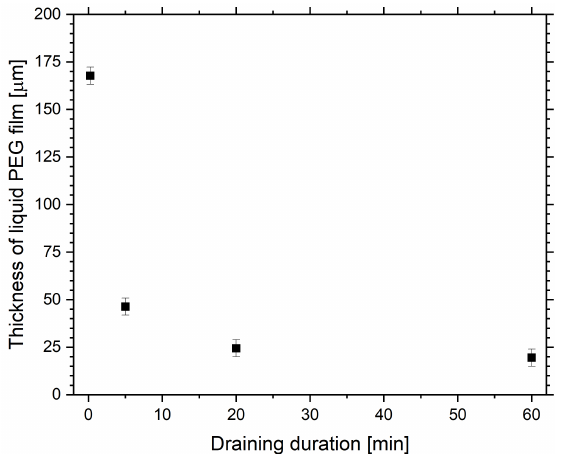
Figure 3. Dependence of the thickness of the liquid PEG substrate on the draining duration during sample